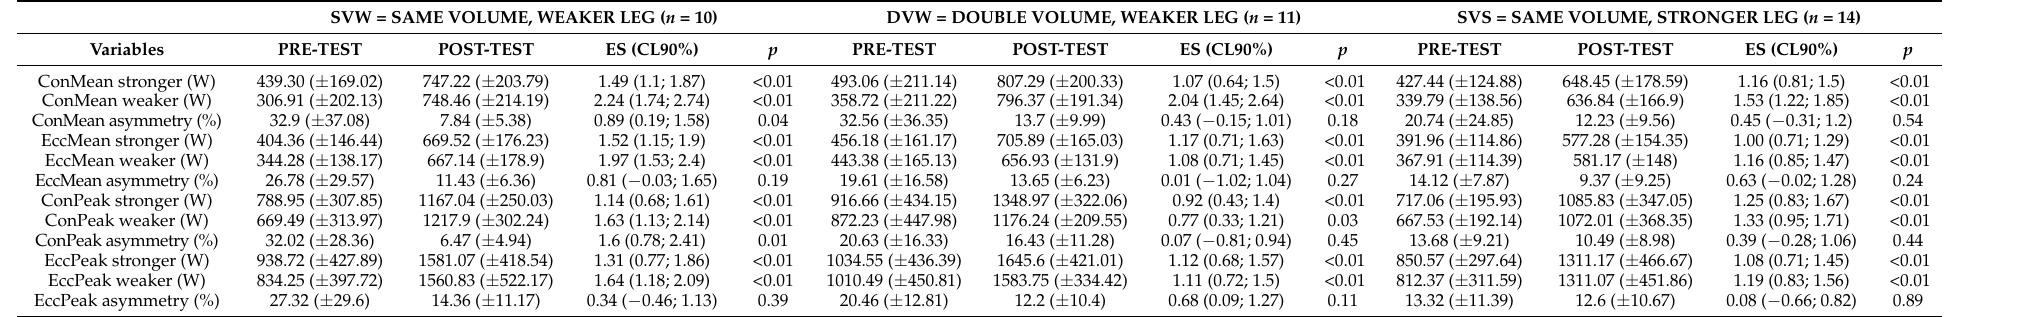
Table 3. Changes in Performance and Asymmetries After Unilateral Eccentric Overload Training With Different Strategies. SVW = SAME VOLUME, WEAKER LEG ( n =